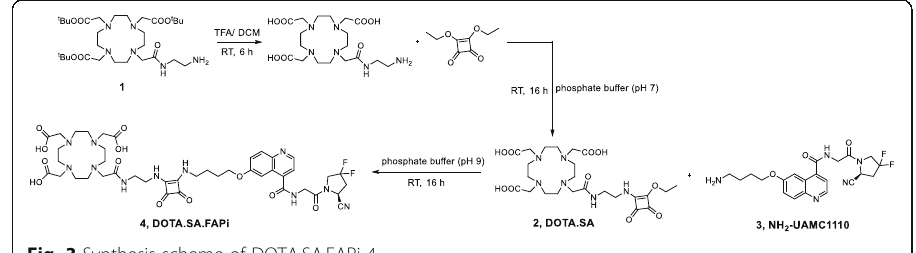
Fig. 3 Synthesis scheme of DOTA.SA.FAPi